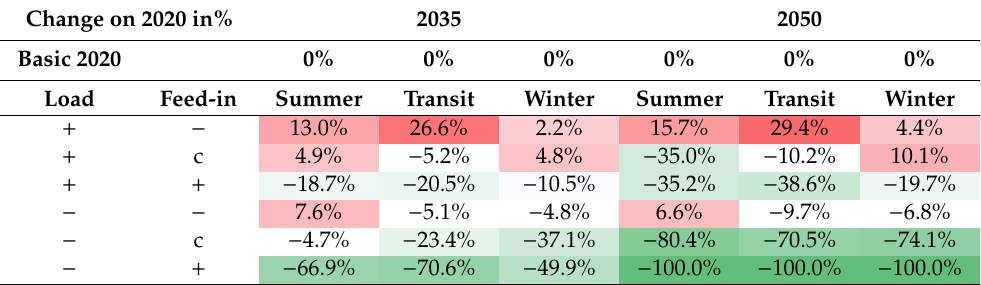
Table 6. Change of external inflows to the Baden-Württemberg grid for di ff erent future